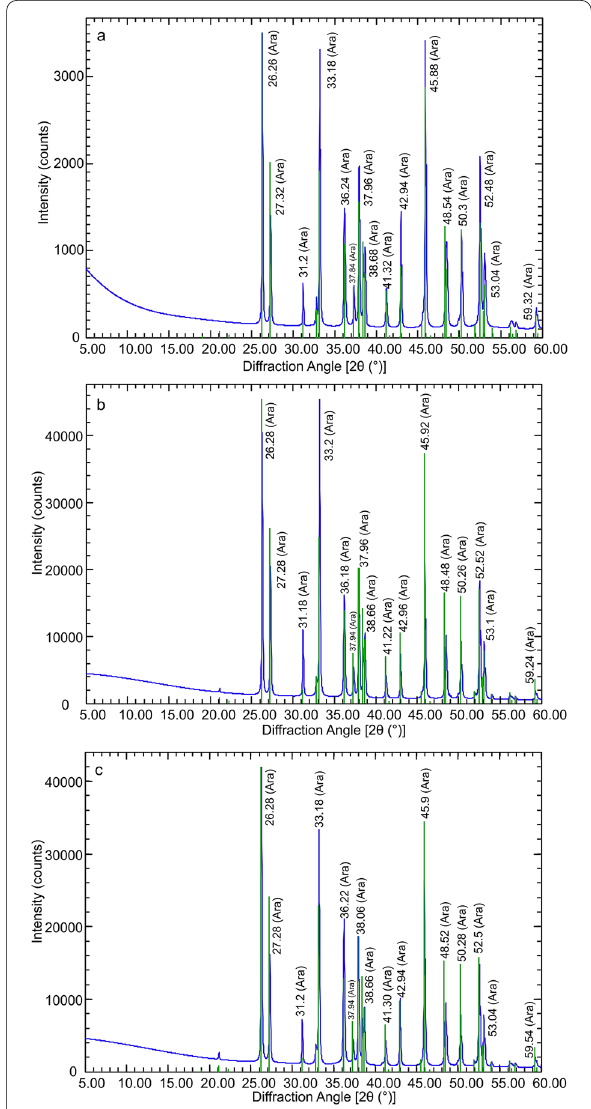
Fig. 8 X-ray diffractograms of a Aphrodina sp. b Claibornicardia sp. and c Caestocorbula sp. Aragonite (Ara) is detected in the composition of all the analysed bivalve genera. Blue lines indicate the obtained curves of the respective samples and green lines indicate the standard d-spacings of aragonite (based on Profex 5.0.2